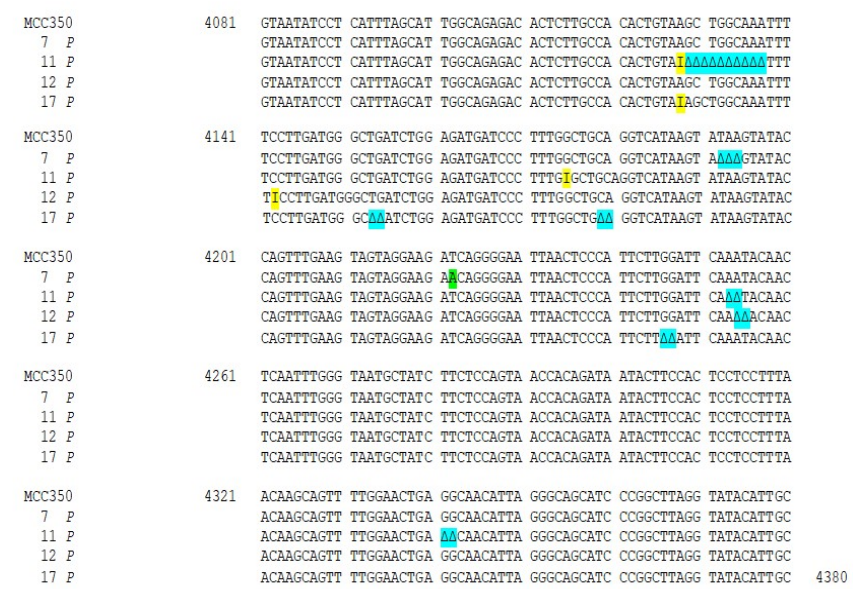
Figure 3. Nucleotide analysis of MCPyV VP1 in plasma samples. The alignment is shown between the nucleotide sequence from 4081 to 4380 of the published sequence of MCPyV in GenBank (MCC350) [20] and that obtained from the sequencing of plasma positive for MCPyV VP1 (MCPyV 7 P, 11 P, 12 P, 17 P). A 4222 T to A transversion was present in 7 P (highlighted in green). Highlighted in blue: a ∆ of a 3 bp (TAA) at nucleotide positions 4192–4194 in 7 P; a 10 bp ∆ , encompassing nucleotide position